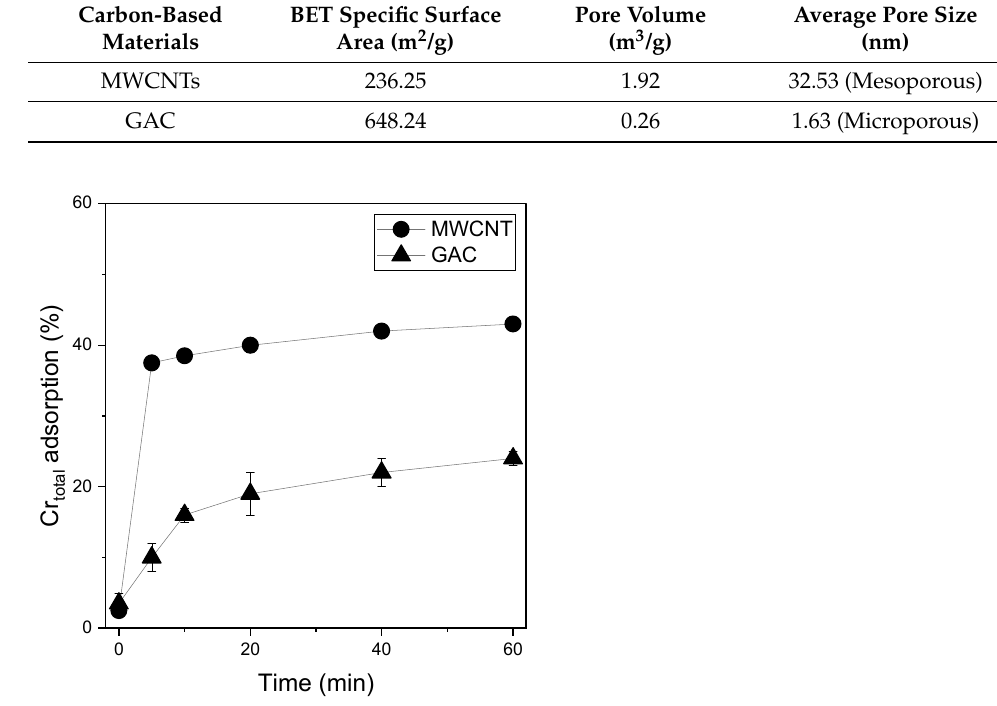
Figure 4. Adsorption of Cr total onto the surface of MWCNT and GAC, respectively, at acidic pH condition ([Cr(VI)] o = 0.1 mM, [MWCNT-Comocat] o = [GAC] o = 2.0 g/L, [pH o = 2.5], anaerobic condition).